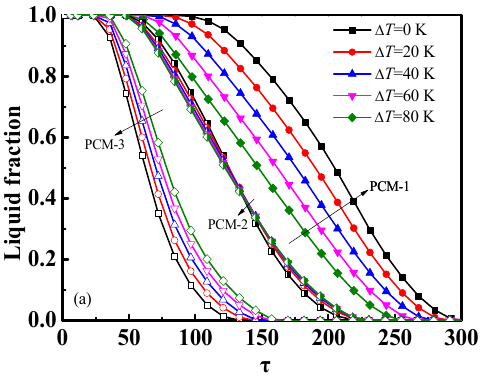
Figure 8. Liquid fractions of the three m ‐ PCMs as a function of dimensionless time at different value of Δ T (empty, half ‐ filled and filled symbols stand for liquid fractions of PCM ‐ 1, PCM ‐ 2 and PCM ‐ 3, respectively).